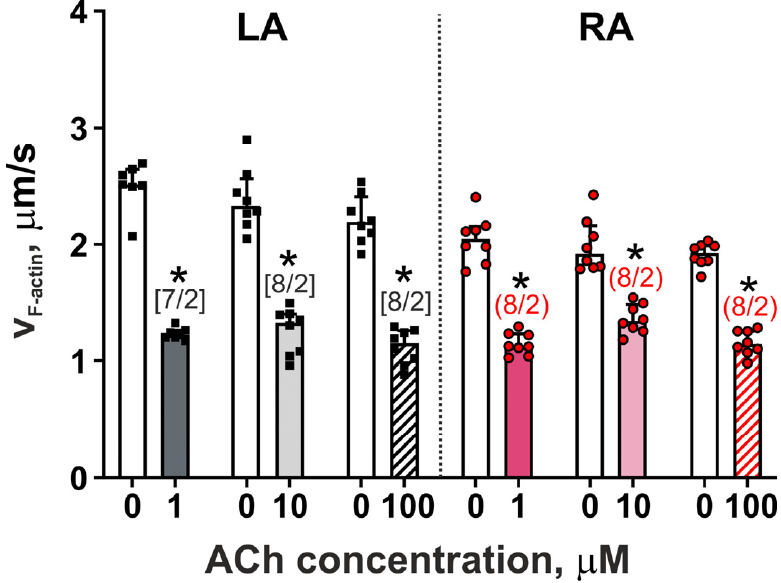
Figure 3. The acute effects of ACh on the sliding velocity of F-actin (v F-actin ) over myosin from LA and RA cardiomyocytes in an in vitro motility assay. The number of n samples from N hearts (n/N) is shown in square brackets [LA] or parentheses (RA). Data are presented as dots (values) and medians (boxes) with interquartile range (bars). The same hearts were used for ACh groups and individual controls. * p < 0.05: 1, 10, and 100 µ M ACh compared to the individual control group (0 µ M ACh), Mann–Whitney